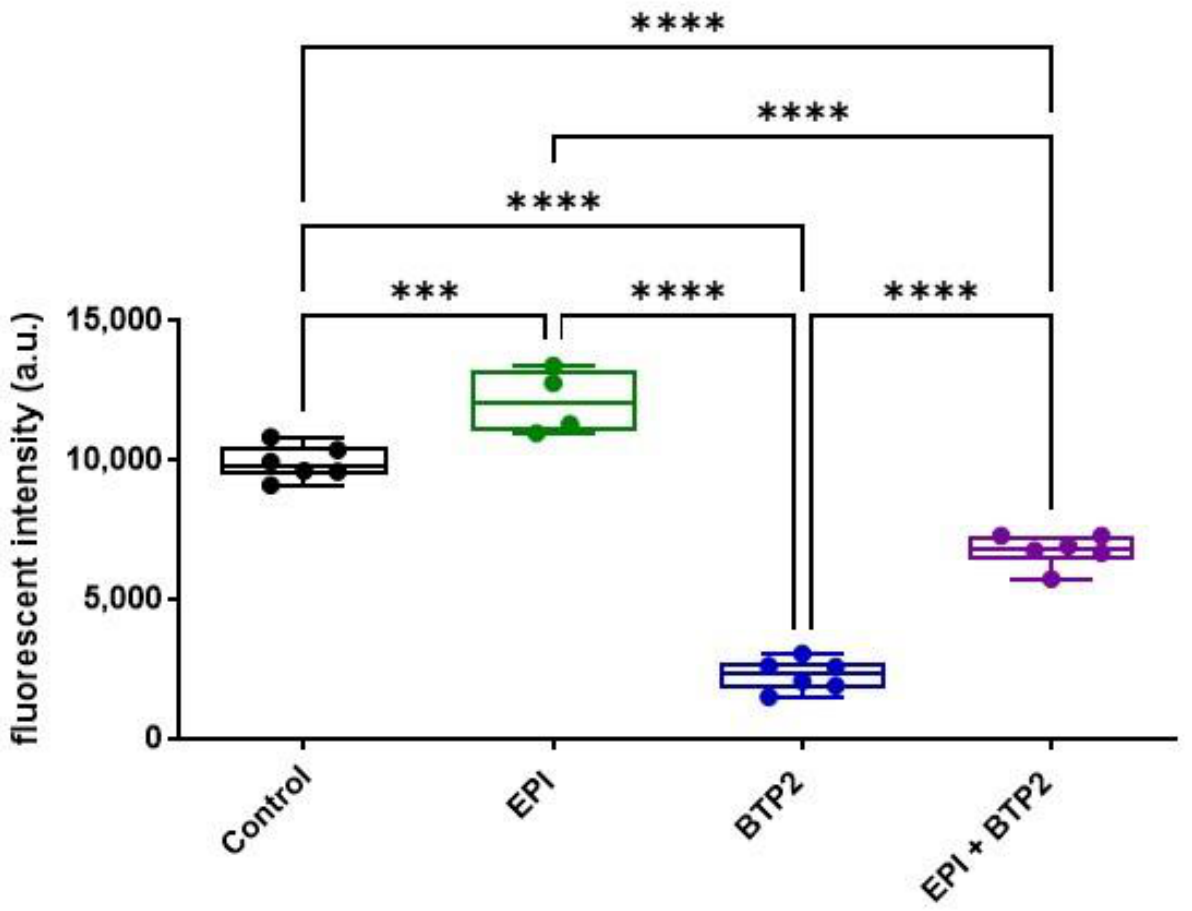
Figure 3. EPI induced ROS production in HL-1 cardiomyocytes. ROS was measured in HL-1 cells by using DHE dye in control group with only resting cells; 1 µ M EPI treatment for 30 min (EPI); 20 µ M BTP2 (BTP2) treatment; 1 µ M EPI together with 20 µ M BTP2 treatment for 30 min (EPI + BTP-2). Quantitative fluorescent intensity (a.u.) from each independent well was showed. n = 6, Mean ± SD. ***: p < 0.001; ****: p < 0.0001. (Based on One Way ANOVA and Bonferroni post hoc